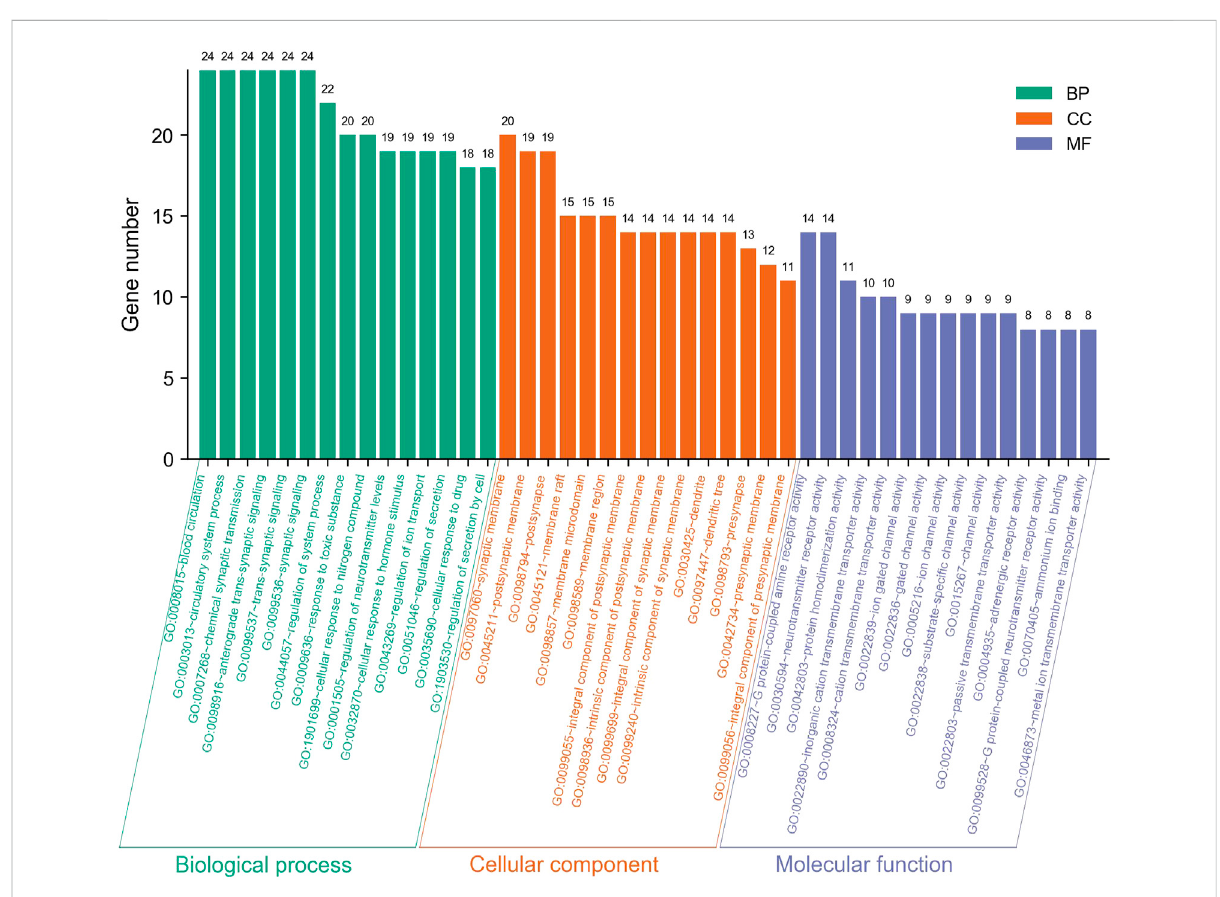
FIGURE 5 Histogram of GO enrichment analysis of Ligusticum chuanxiong-Piper longum couplet medicines in the treatment of migraine (top 15).